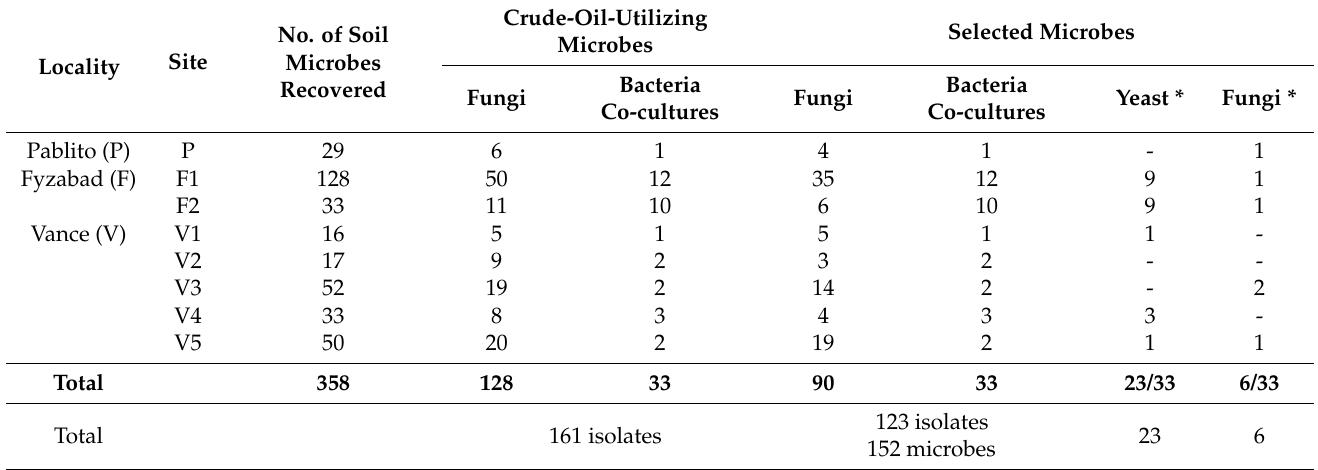
* The breakdown of the number of yeast and fungi that were in co-culture with a bacterial